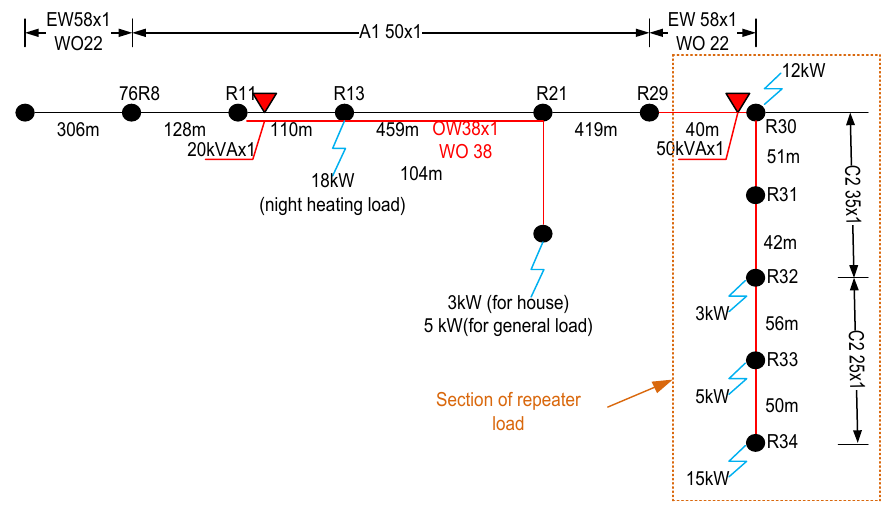
Figure 1. Schematic and information of the selected applicable medium-voltage alternative current (MVAC) distribution line for communication repeaters.